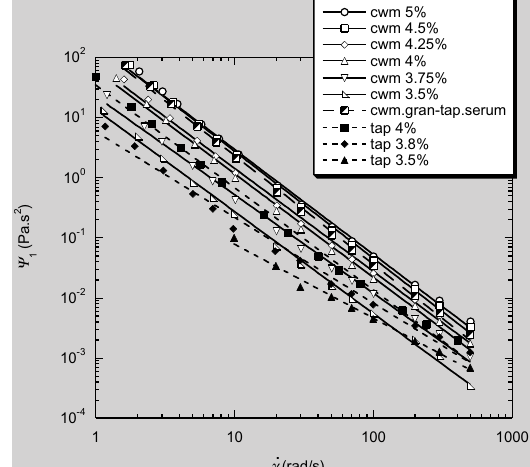
Figure 4 (left): First normal stress coefficient, y 1 , – shear rate, g · , down curves for cross-linked waxy maize (CWM) and tapioca starch dispersions (SDs) at different weight concentrations and CWM granules in tapioca serum. Figure 5: First normal stress coefficient from flow test down curve (fnsc), first normal stress coefficient predicted with Eq. 4 (dyn), and first normal stress coefficient predicted with Eq. 5 using different values of the empirical factor K (K = 1, K = 2, K = 3) for cross-linked waxy maize (CWM) at a) (right ab0ve) 5 % and b) (right below) 3.5 %